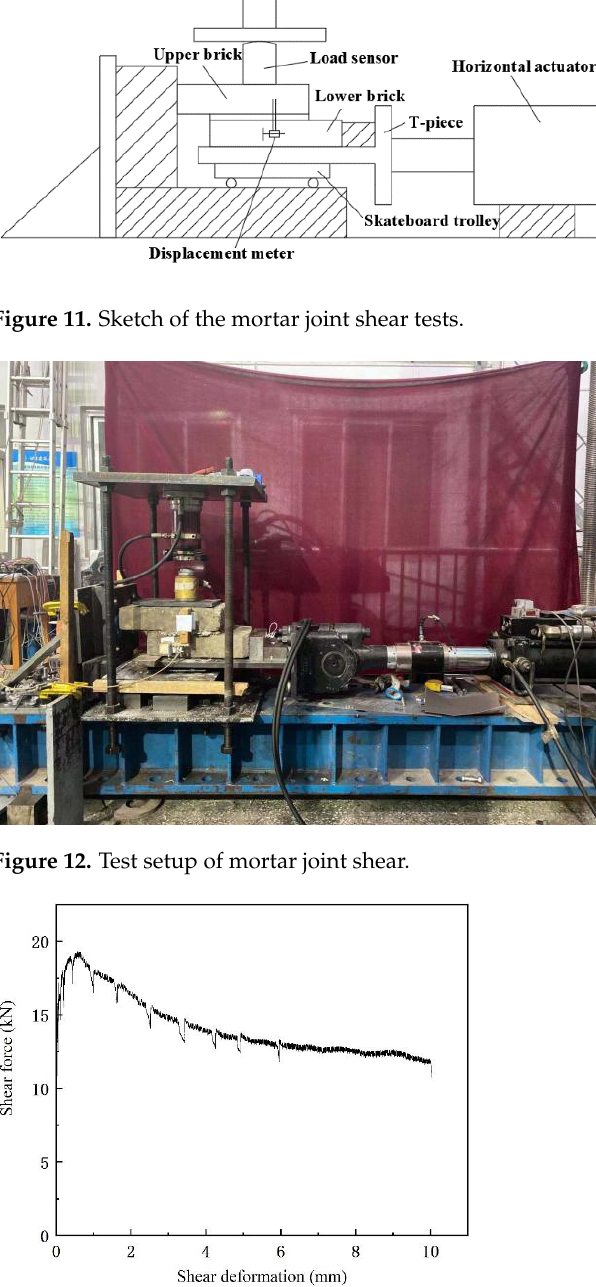
Figure 14. Load – displacement curves of the mortar joint friction tests. 5. Modeling in Blender with Physics Engine The 3D models of side walls ’ flat and sloped sections are set up in Blender with Bullet physics engine plugin (Appendix S1 shows main modeling steps and inputs). The flat section model is 9.3 m in length, 4.0 m in width, and 5.5 m in height (Figure 15), which includes a battlement wall of 1.1 m in height, parapet walls of 0.5 m in height, and base wall of 3.9 m in height. The flat section’s external layer has 12 layers of stones with infilled rubbles, each of which is 0.15 m × 0.17 m × 0.2 m on average. The sloped section model is 6.0 m in length, 5.0 m in width, and 3.9 m in height (Figure 16), which comprises a battlement wall (0.9 m in height), a parapet wall (0.8 m in height), and a base wall (2.2 m in height). The sloped section’s external layer has seven layers of stones with infilled rub- bles, each of which has a dimension of 0.15 m × 0.18 m × 0.17 m . Figure 15. Flat section model of the Great Wall.